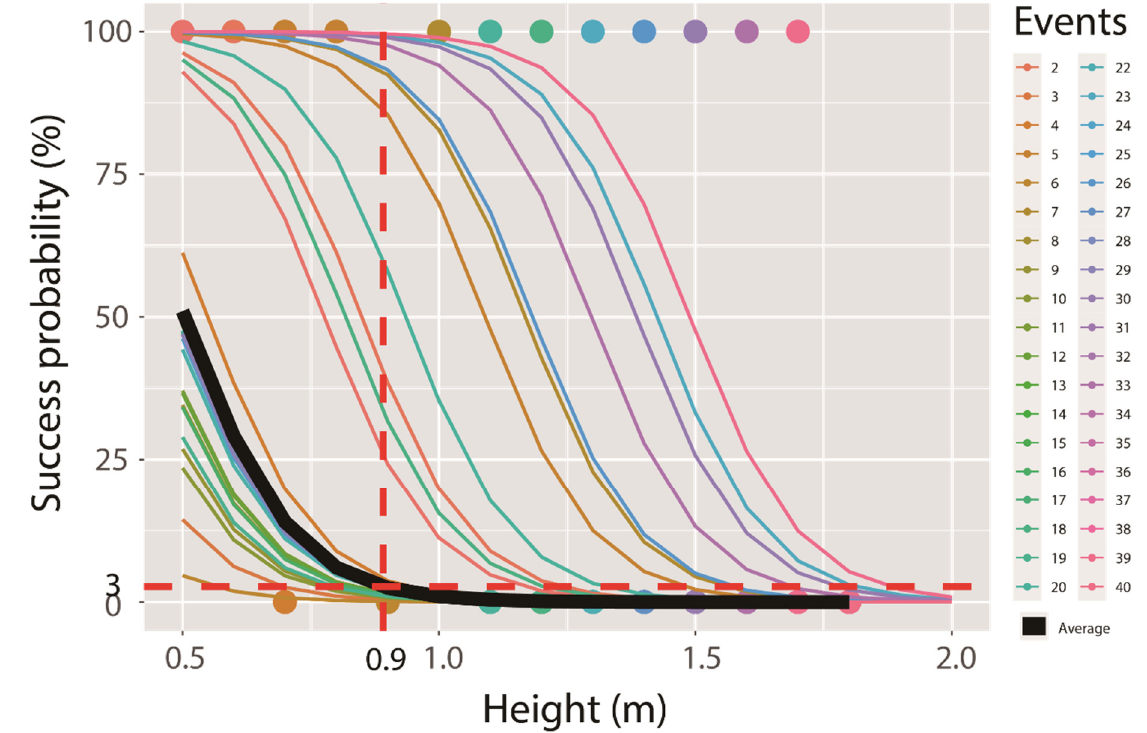
Figure 3. Regression lines according to the binary logistic generalised linear mixed model using fence height (m) from 40 events. The bold black line indicates the marginal relationship, while the thin coloured lines indicate the conditional relationships. The vertical and horizontal dotted lines are for calculating the threshold of fence height at the level of optimal cut-off that equalised specificity and sensitivity.